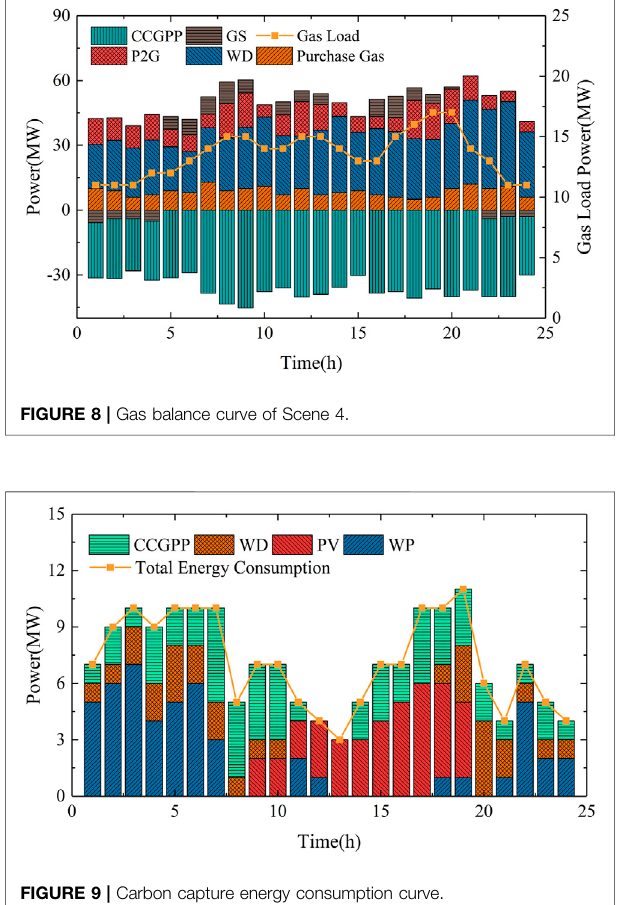
FIGURE 11 | Wind power and photovoltaic power curtailment in various scenes.